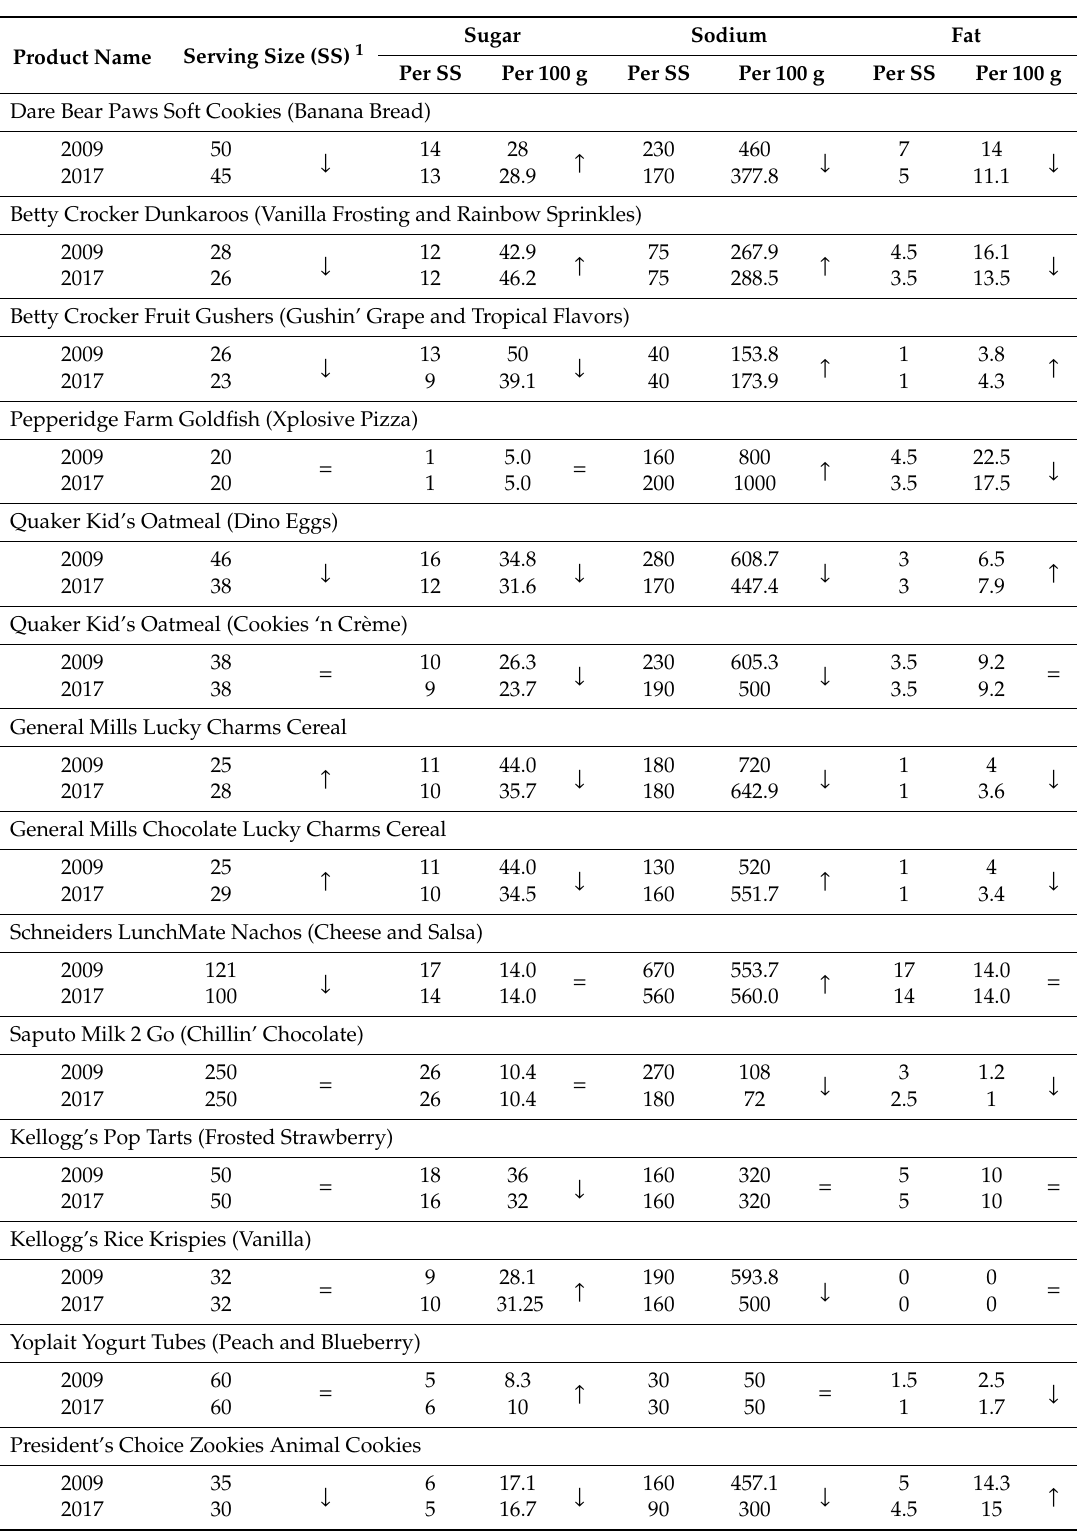
Table 3. Comparison in serving size and nutrient content for identical children’s food products from 2009 and